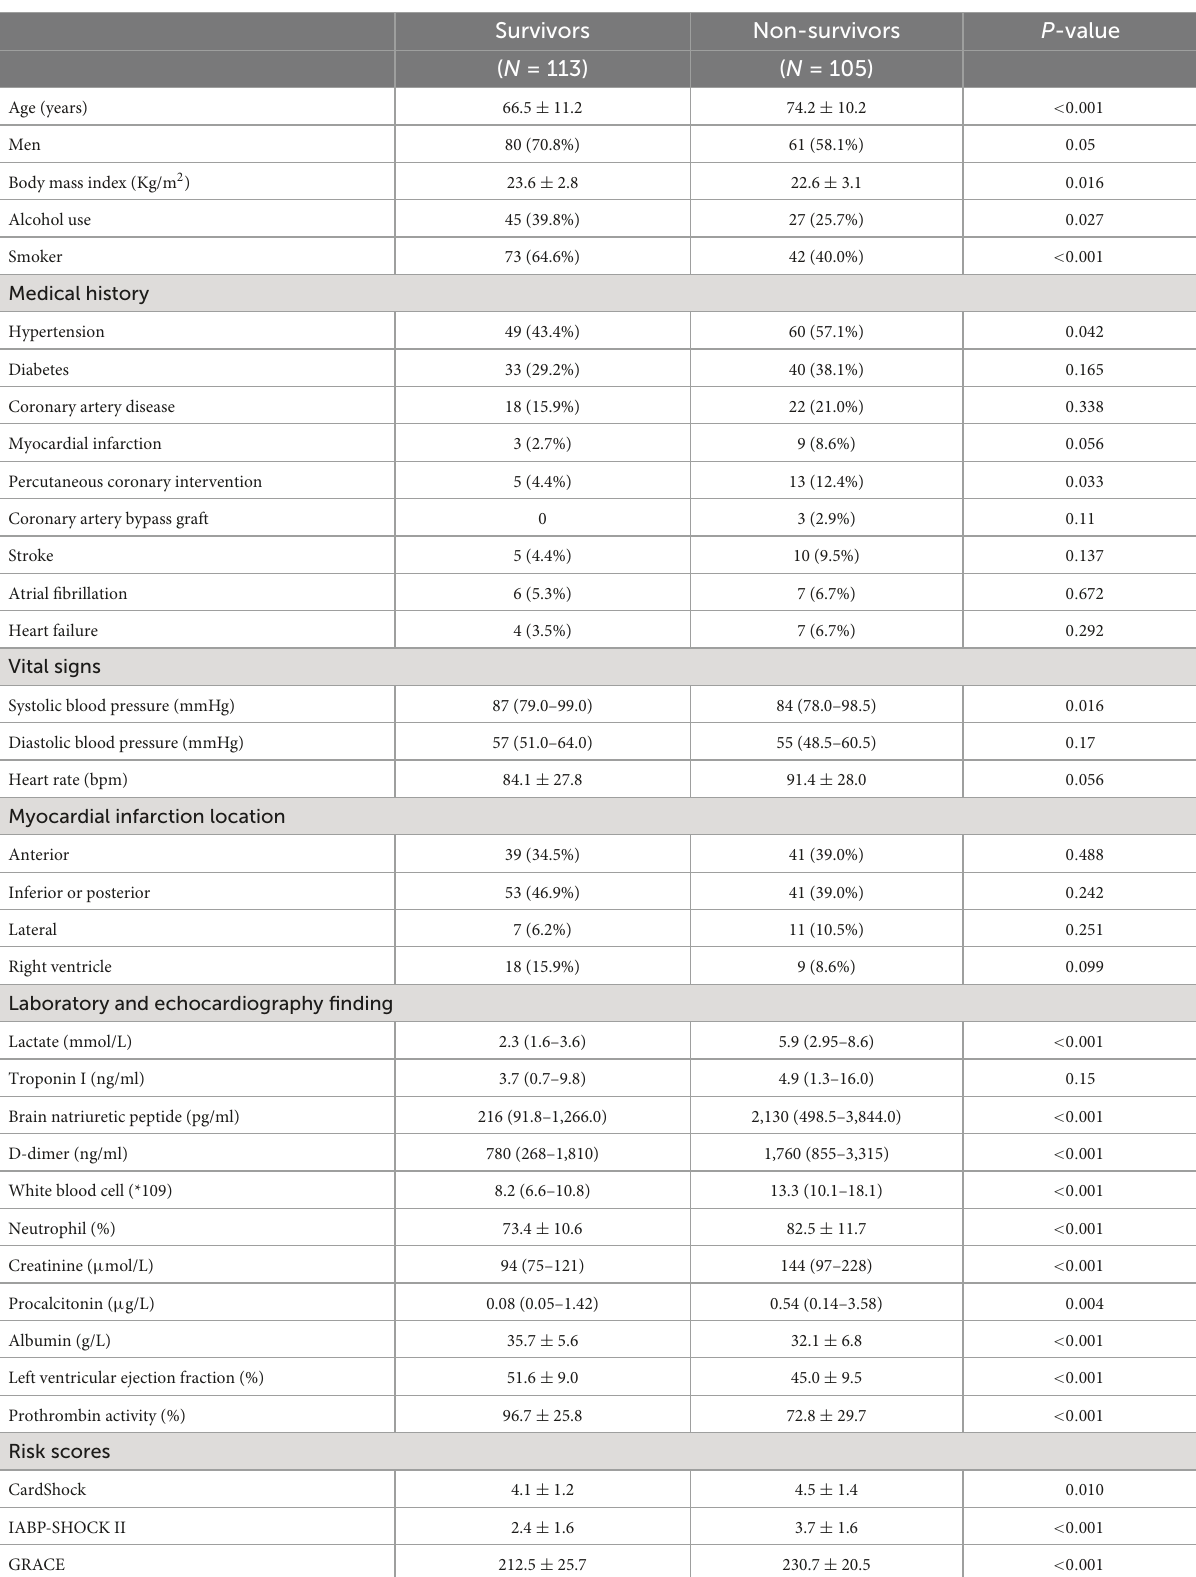
TABLE 1 Comparison of baseline characteristics stratified by the primary